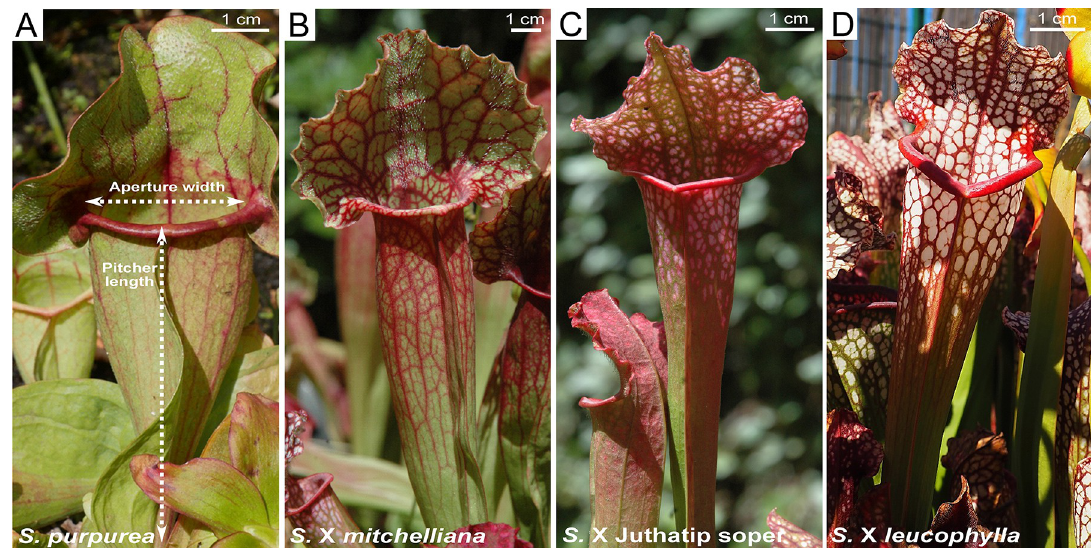
Fig 1. Pitchers of the four studied Sarracenia taxa. (A) S . purpurea , (B) S . X mitchelliana , (C) S . X Juthatip soper, (D) S . X leucophylla .